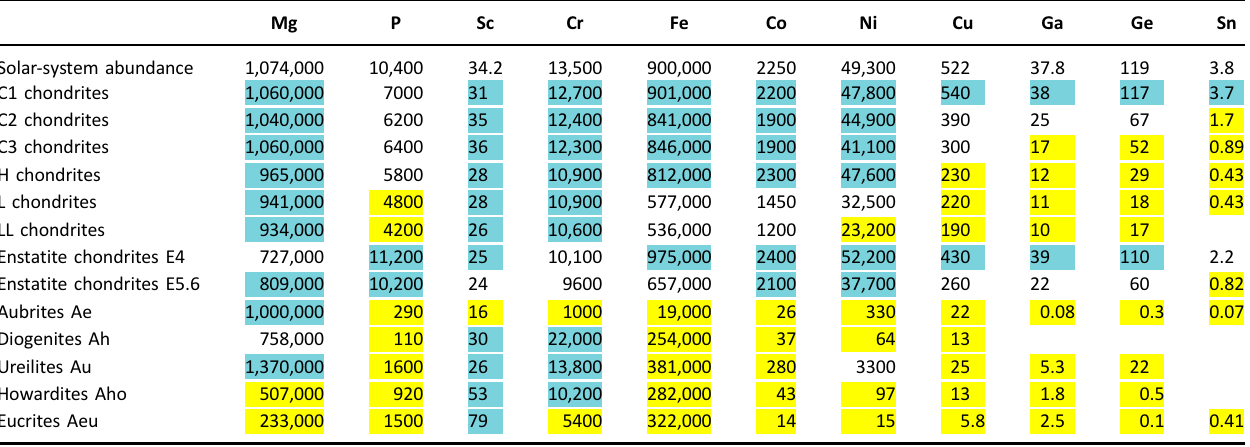
Table 3. Solar-system abundances of different elements and mean values for the abundances of these elements in different stony meteorite classes, in atoms per million silicon atoms.